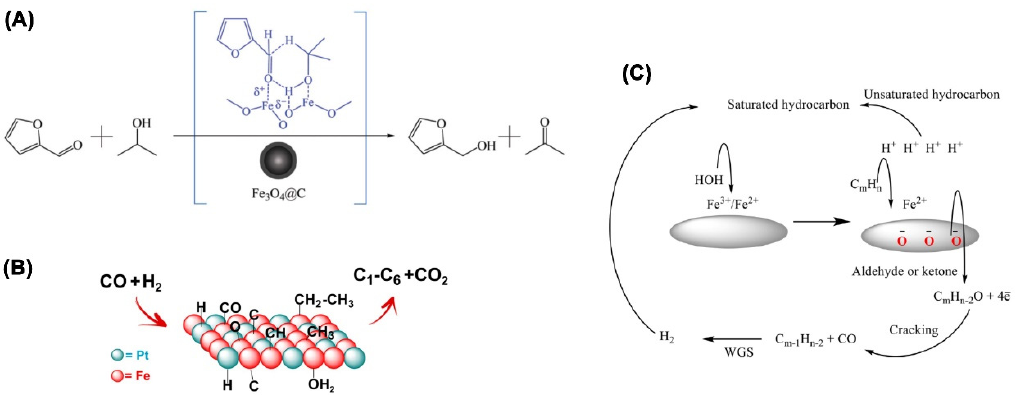
Figure 11. ( A ) Reaction mechanism for CTH of FF over Fe 3 O 4 @C [52], Copyright 2020 Royal Society of Chemistry. ( B ) Schematic illustrating the reaction mechanism over Fe x O y @Pt NPs during Fischer– Tropsch synthesis [125], Copyright 2018 American Chemical Society. ( C ) Mechanism for the up-